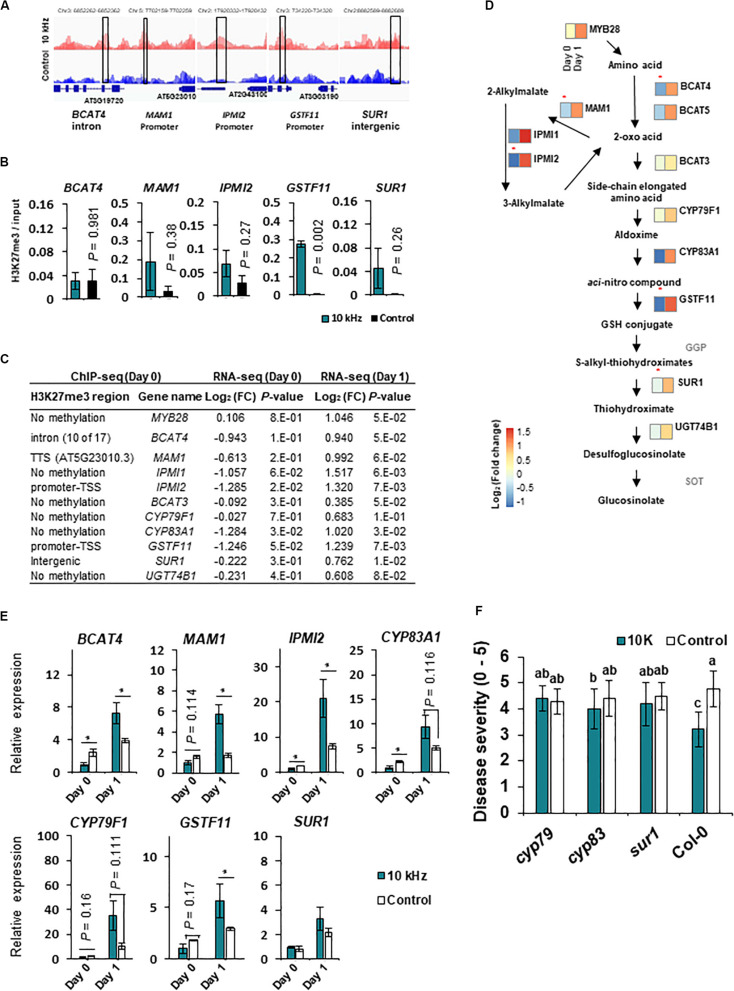
SV (10 kHz) modulates the expression of glucosinolate (GS) biosynthesis genes through chromatin remodeling. (A) Integrated Genome Browser (IGB) view of H3K27me3 modifications, as determined by ChIP-seq. Data represent the average of three biological replicates. Y-axis scale is identical for the different tracks. Blue diagrams indicate gene structure; boxes represent the regions tested in ChIP-qPCR experiments. (B) ChIP-qPCR validation (n = 3). (C,D) Expression of aliphatic GS biosynthesis genes. Heatmaps show expression levels of genes differentially expressed between 10 kHz-treated and control plants (n = 3–4). Asterisk indicates the enrichment of H3K27me3 modification in 10 kHz-treated plants vs. control plants. (E) Validation of GS biosynthesis gene expression by qPCR (n = 3–4; *p < 0.05). (F) Disease severity in 10 kHz-treated and control GS biosynthesis mutant plants at 14 dpi with R. solanacearum. Data represent mean ± SE. Different letters indicate significant differences [n = 10; p < 0.05; Fisher’s least significant difference (LSD) test].